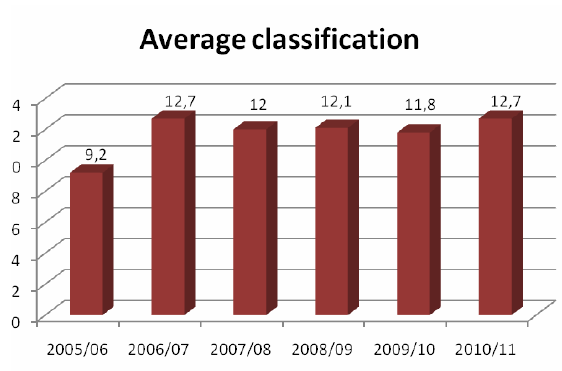
Figure 4. Average classification (out of 20) along the last five aca- demic